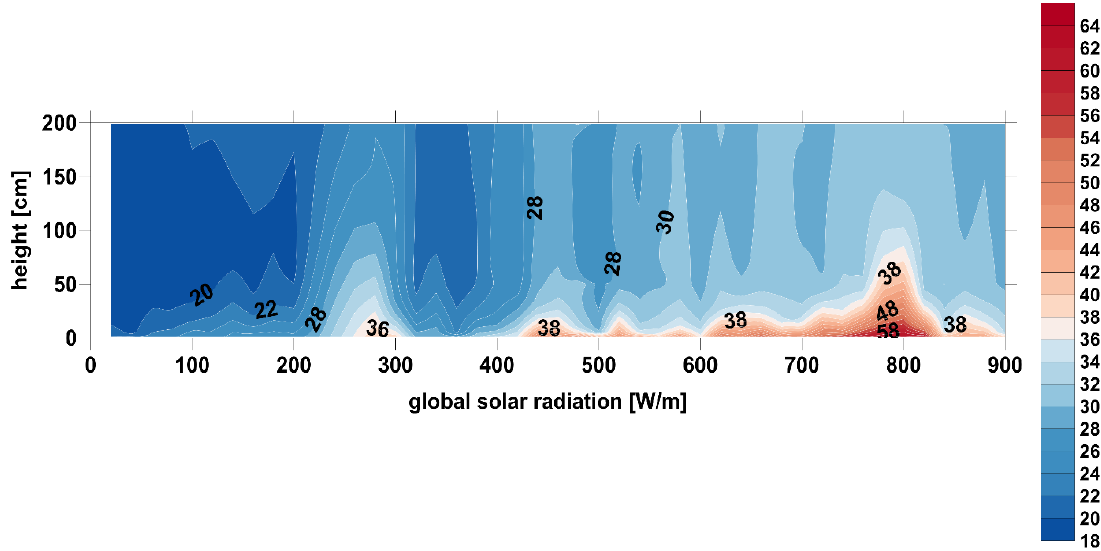
Figure 9. Temperature (°C) of common artificial urban surface asphalt and adjacent air during a cloudless tropical day—effect of global solar radiation (average from both representative days from sunrise to sunset).